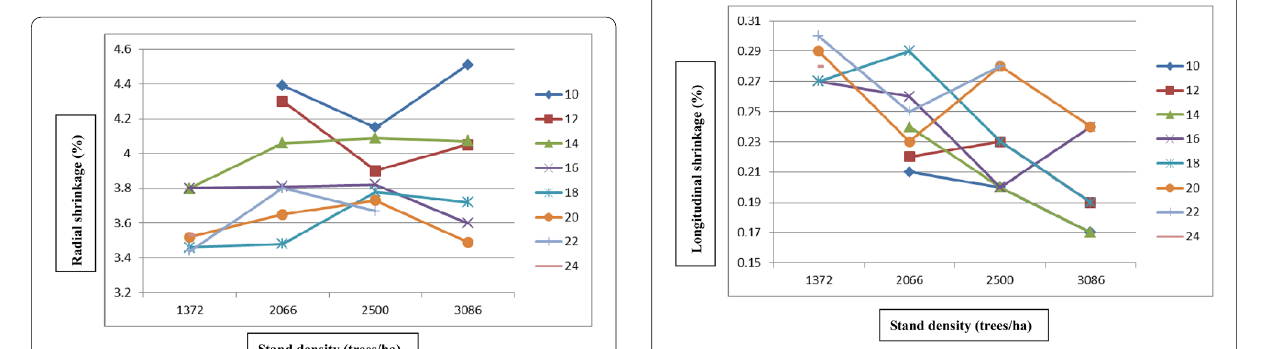
Fig. 5 Longitudinal shrinkage in relation to stand density and DBH